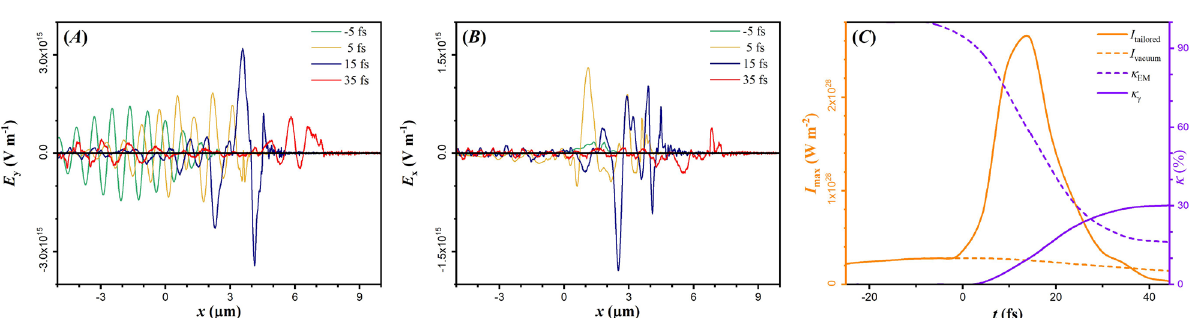
Figure 3. ( A ) Line-out of E y , and ( B ) line-out of E x along the laser propagation axis at various times, as noted on the legend. Note that the laser is linearly polarized, along ˆ y . ( C ) The left axis shows the maximum field intensity as a function of simulation time; the black dashed baseline denotes the field intensity expected in the focal spot, without the target. The right axis shows with the dashed purple line the amount of laser energy transferred to all target particles, while the solid purple line shows the percentage of the remaining laser field energy, κ γ , as a function of